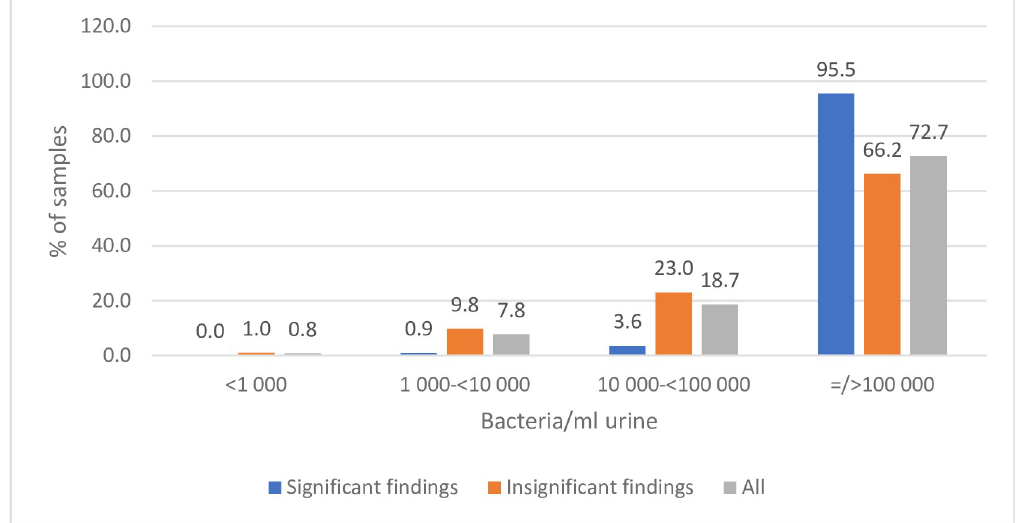
Fig 1. Flowcytometric findings (bact./mL) in culture plated with significant growth (significant findings) and non- significant growth (non-significant findings).